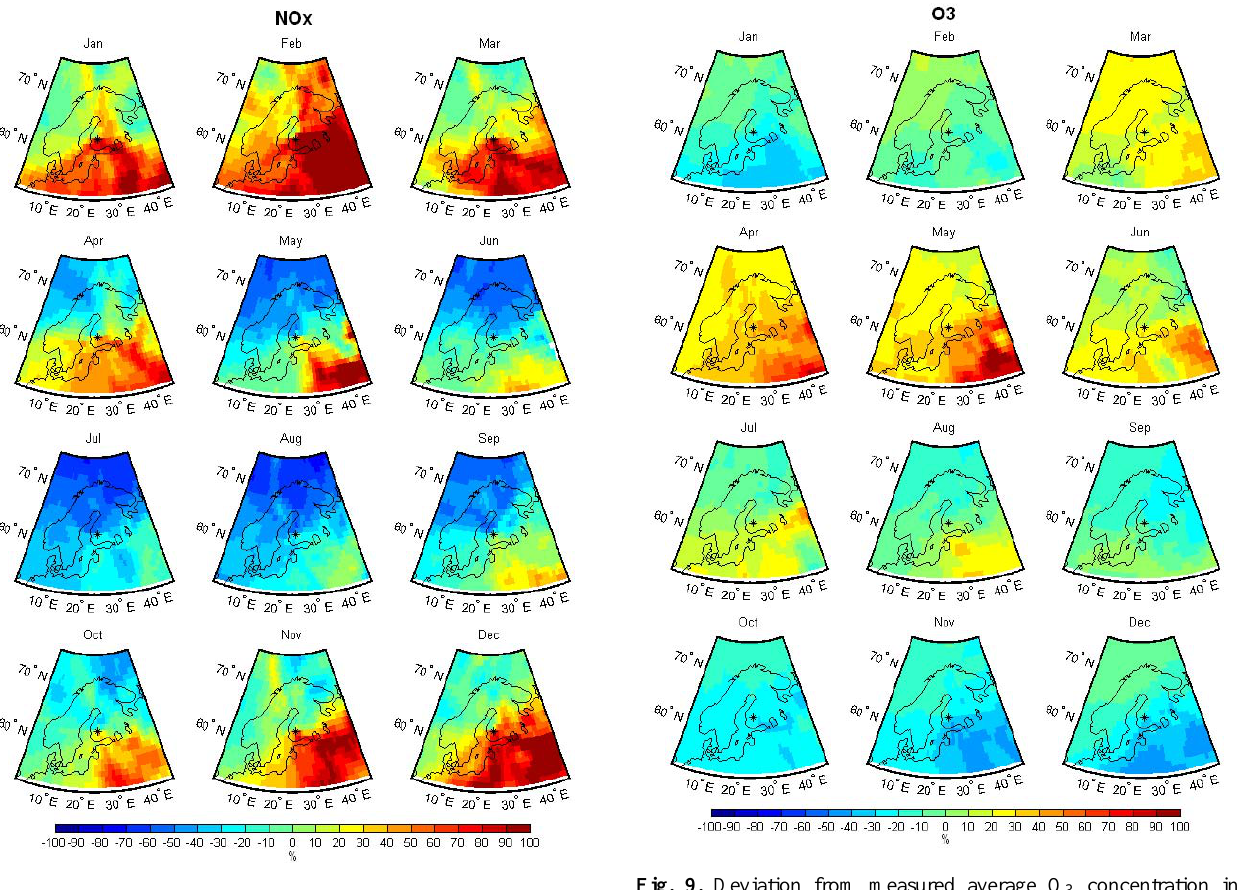
Fig. 8. Deviation from measured average NO x concentration in Hyyti¨al¨a according to transport directions. Monthly concentration fields are produced for years 1996–2008. Fields are normalized to the mean concentration (1.78 ppb) of the whole measurement pe- riod. Hyyti¨al¨a is marked with a star.